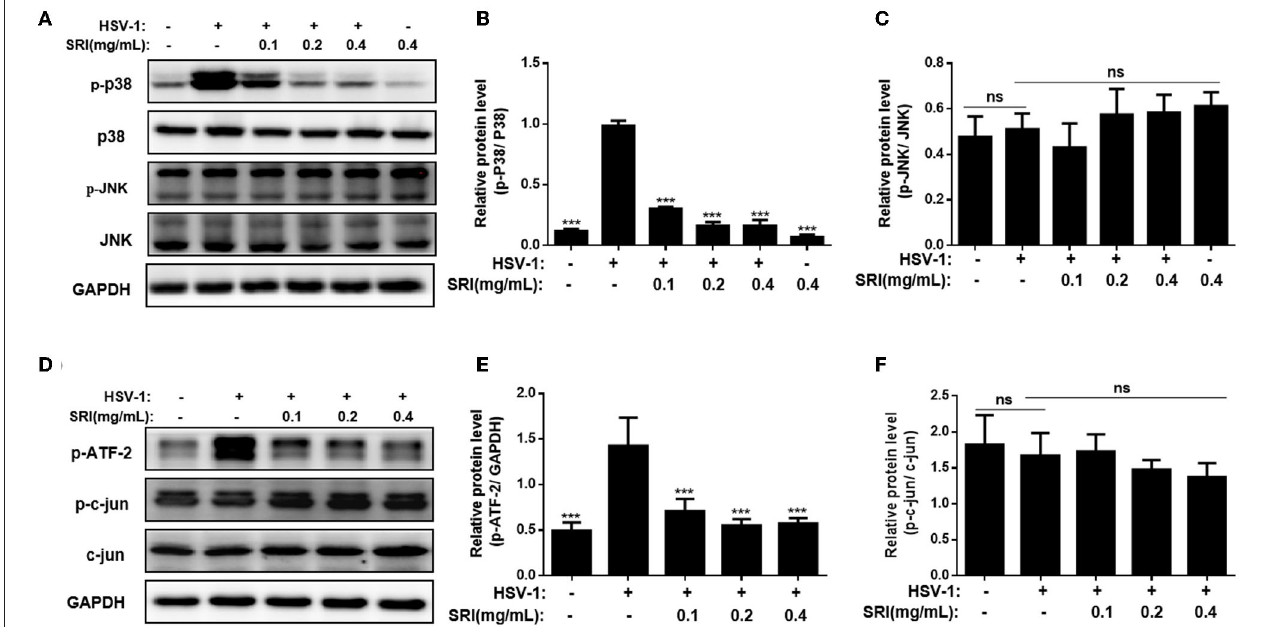
FIGURE 7 | SRI restrained HSV-1 replication through blocking of P38 MAPK pathway. (A,D) The infected cells of HSV-1 (MOI = 1) were treated without or with SRI (0.1, 0.2, and 0.4 mg/mL), and then the protein levels of p-p38, p38, JNK, p-JNK, p-ATF-2, p-c-jun, and c-jun were evaluated through Western blot analysis. Blots were also probed for GAPDH and tubulin proteins as loading controls. (B,C,E,F) Plots quantifying the immunoblots as ratios for p-P38/P38 (B) , p-JNK/JNK (C) , p-ATF-2/GAPDH (E) , and p-c-jun/c-jun (F) , respectively. The results were presented as mean ± SD. *** p < 0.001, vs. HSV-1 group; ns, not